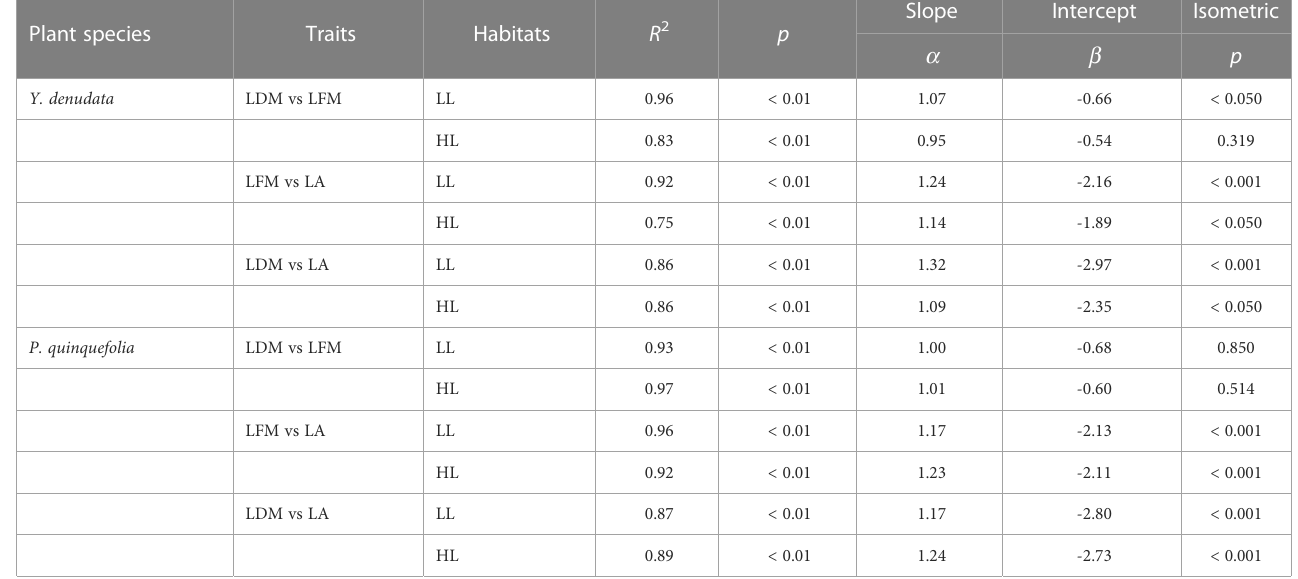
TABLE 3 Scaling relationships of leaf traits in urban plants under different light habitats. Plant species Traits Habitats R 2 p